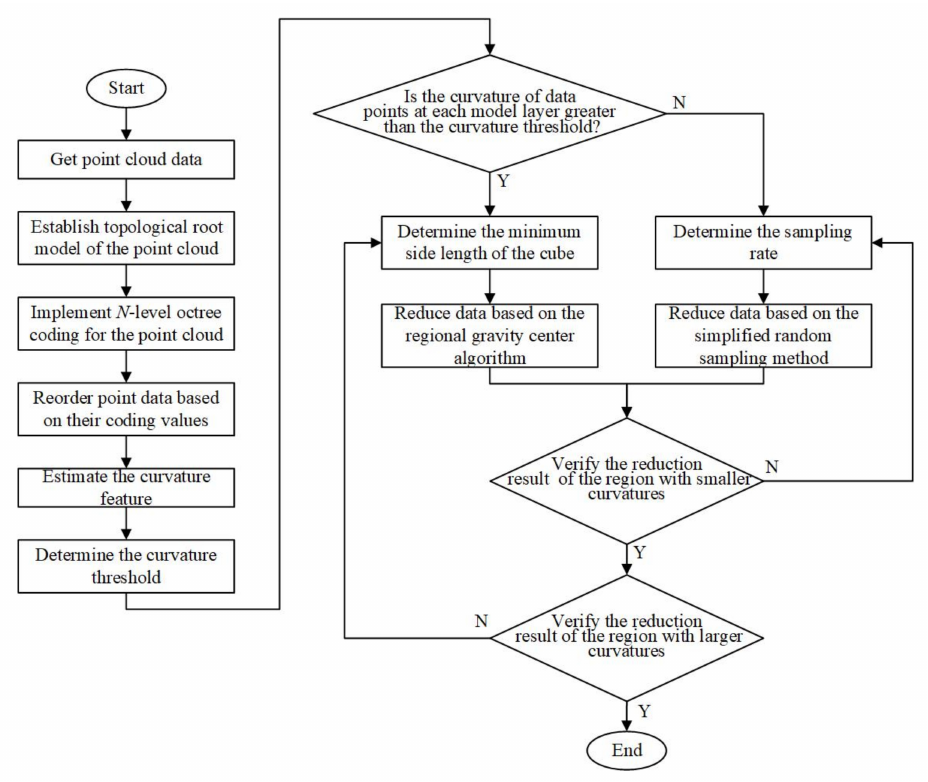
Figure 2. The main procedures of the proposed simplification